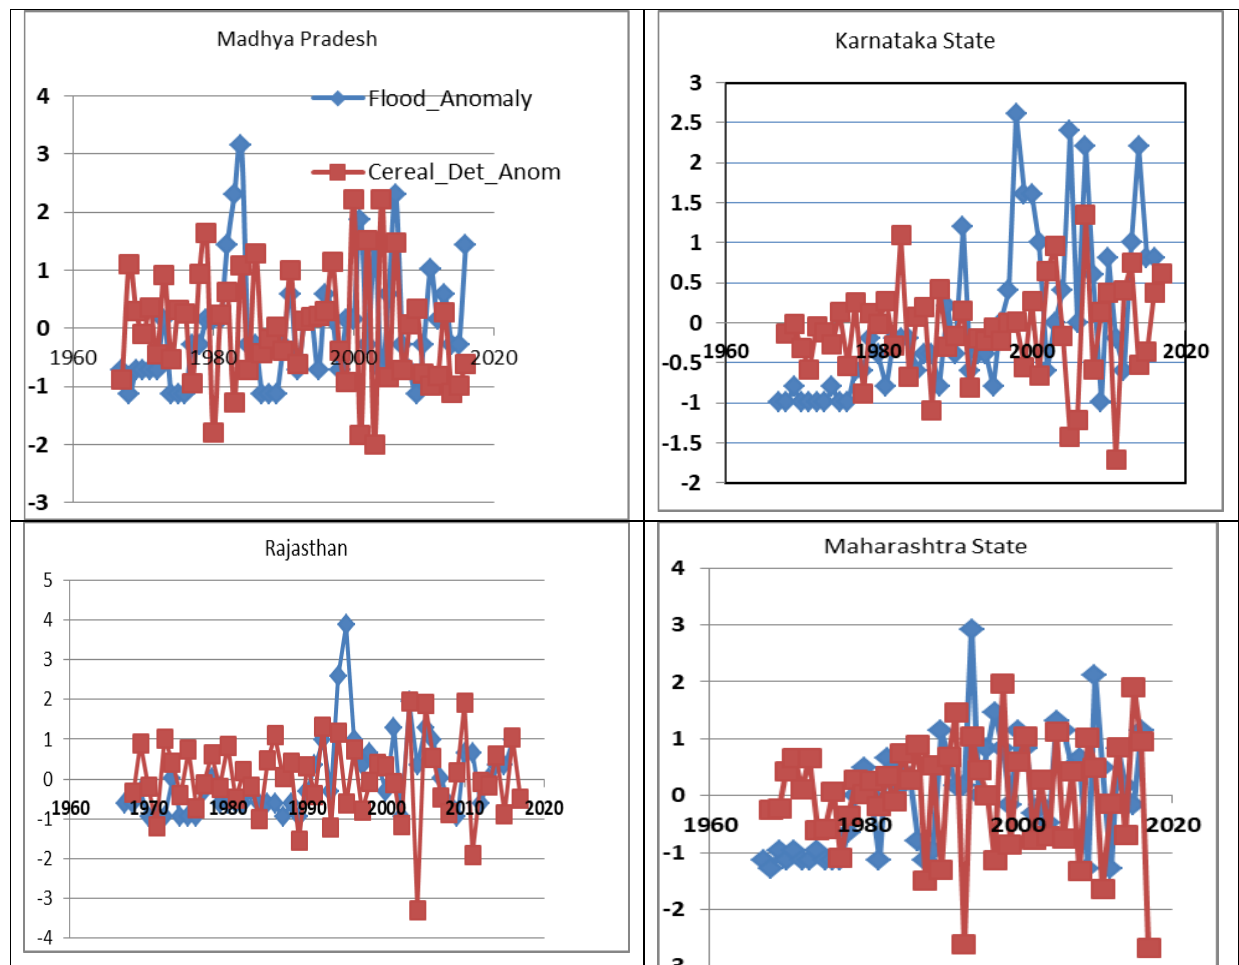
Figure 7 Flood anomaly Vs Total Kharif Cereal Detrended Yield for various States having highest number of Flood